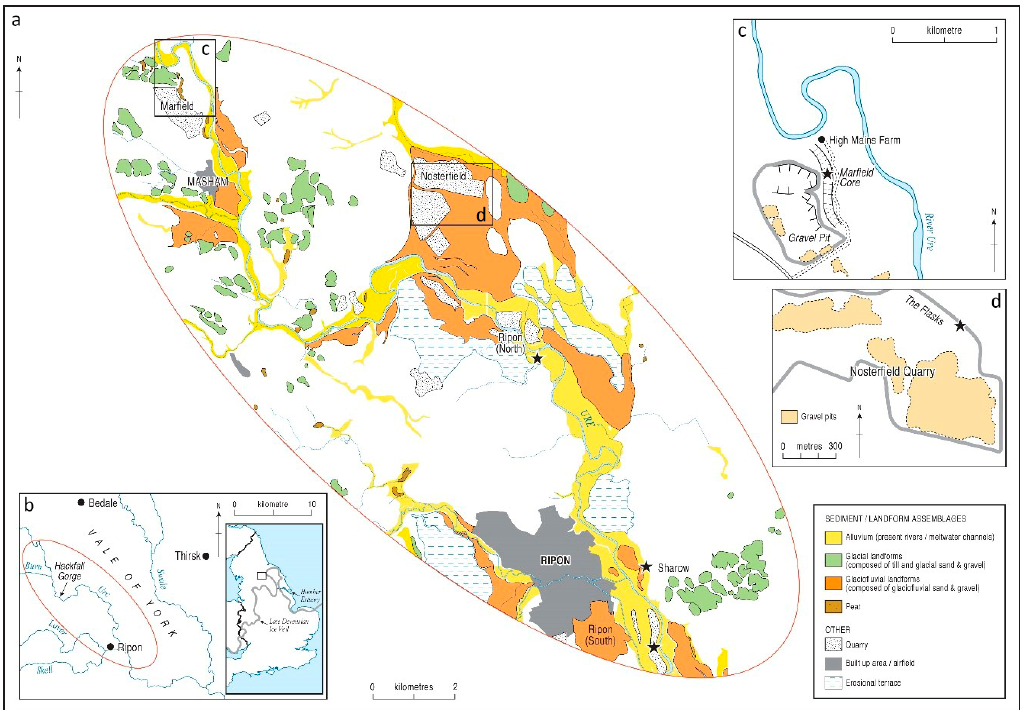
Figure 1. Results of our field mapping of the distribution of river alluvium and other surficial sediments in the Ure valley ( a ) and location of the Ure valley between Marfield and Ripon in North Yorkshire ( b ). The insets show details of the two main study sites at Marfield ( c ) and Nosterfield, The Flasks 69 ( d ). Other sites at Ripon North, Sharow Mires and Ripon South are also shown, and all core locations are indicated by black stars. A schematic cross-section of the valley between Marfield and the Ure south of Ripon, showing major sites and features, is presented below.